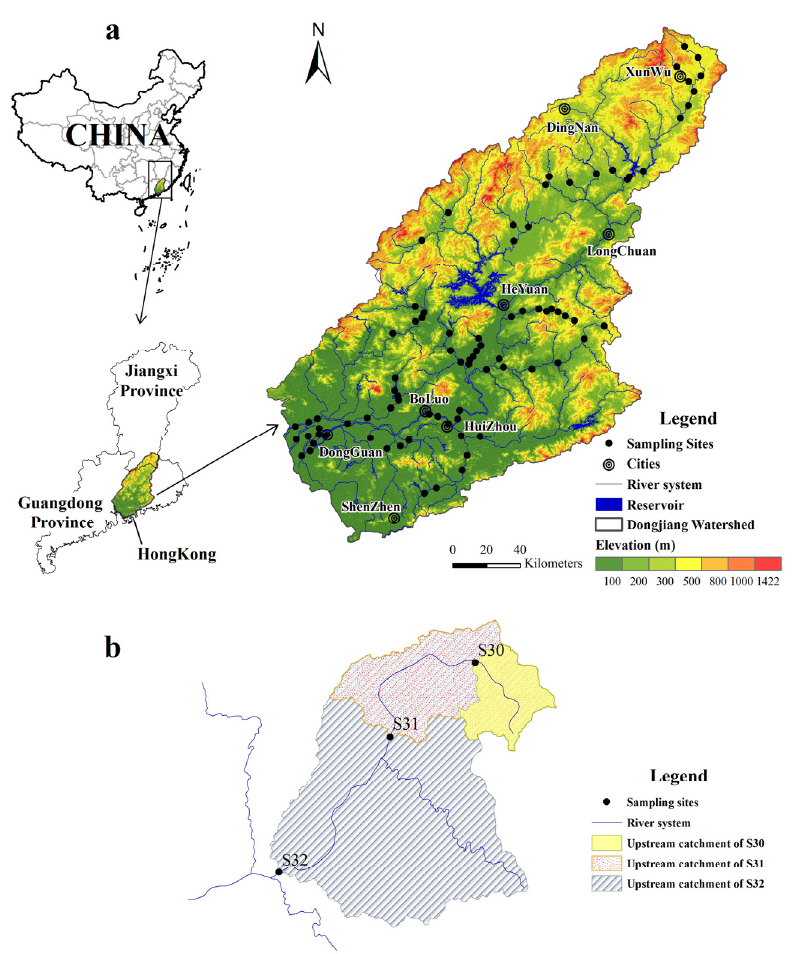
Figure 1. ( a ) The topography and the locations of the Dongjiang River basin and sampling sites; ( b ) Schematic of upstream catchment delineation on the basis of the positions of the sampling